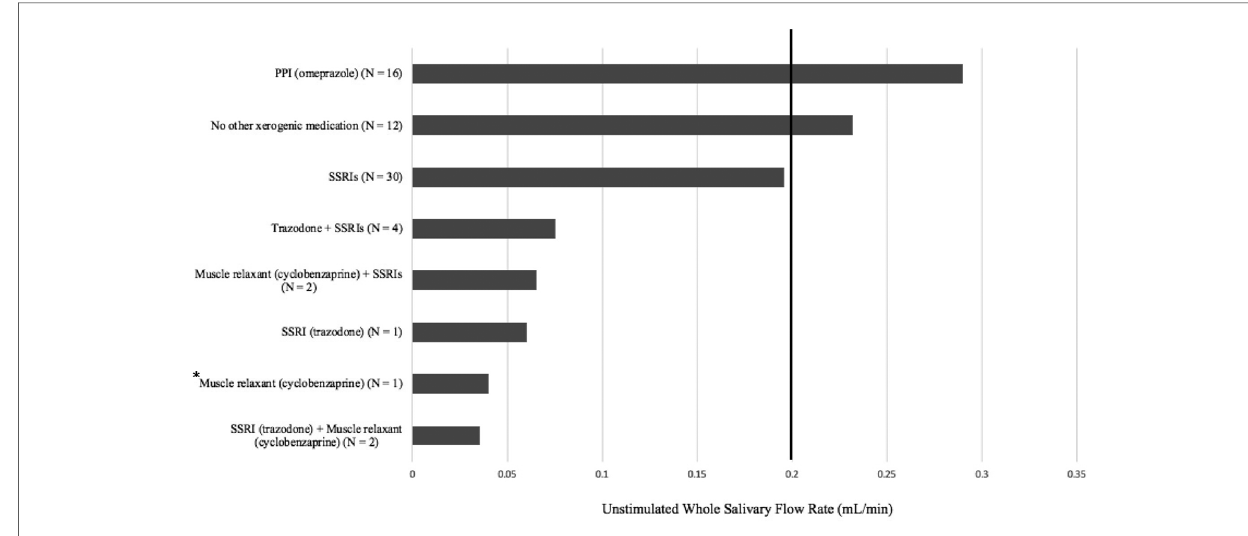
FIGURE 2 Type of medication and unstimulated whole salivary fl ow rate